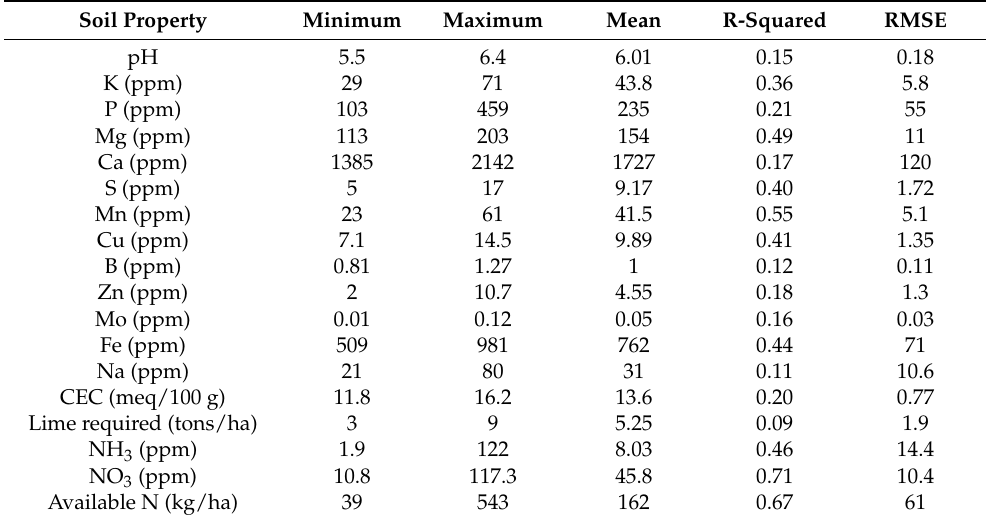
Table 3. Performance of neural network model estimating soil properties from crop spectra at Balruddery agricultural site. RMSE, Root Mean Squared